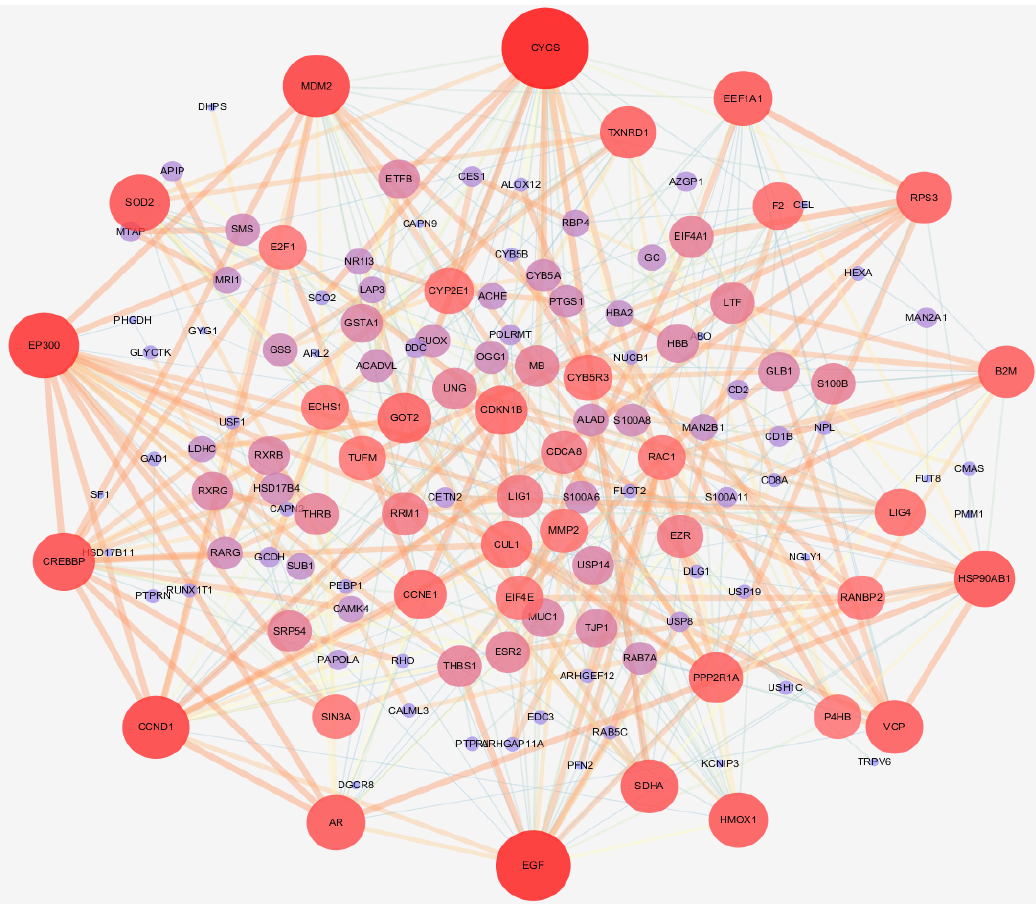
Figure 5. protein–protein interaction diagram.